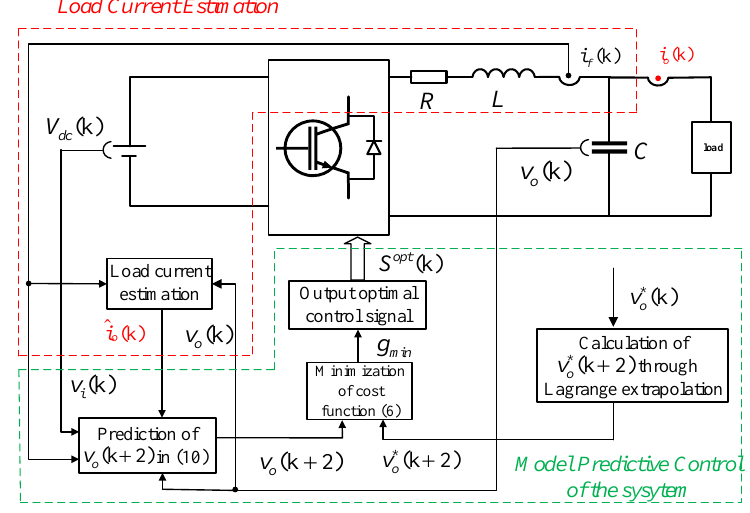
Figure 3. Block diagram of proposed control